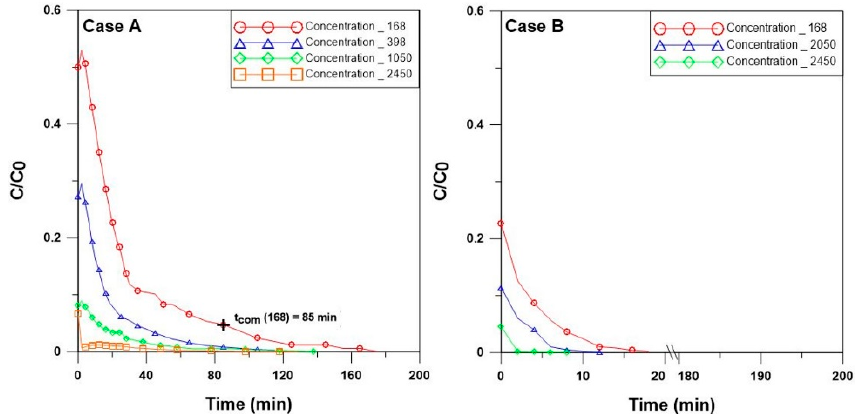
Figure 3. Breakthrough curves under different tracer input density obtained from laboratory-scale push-drift-pull tracer tests (case ( A ): 10 min of drift time, 3.0 × 10 − 3 hydraulic gradient, case ( B ): 5 min of drift time, 1.2 × 10 − 2 hydraulic gradient).